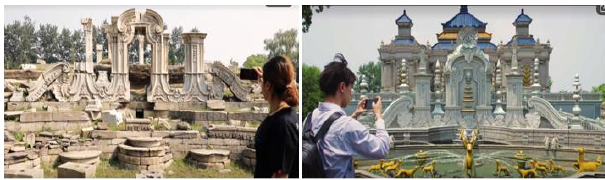
Fig. 7. AR Historic Building